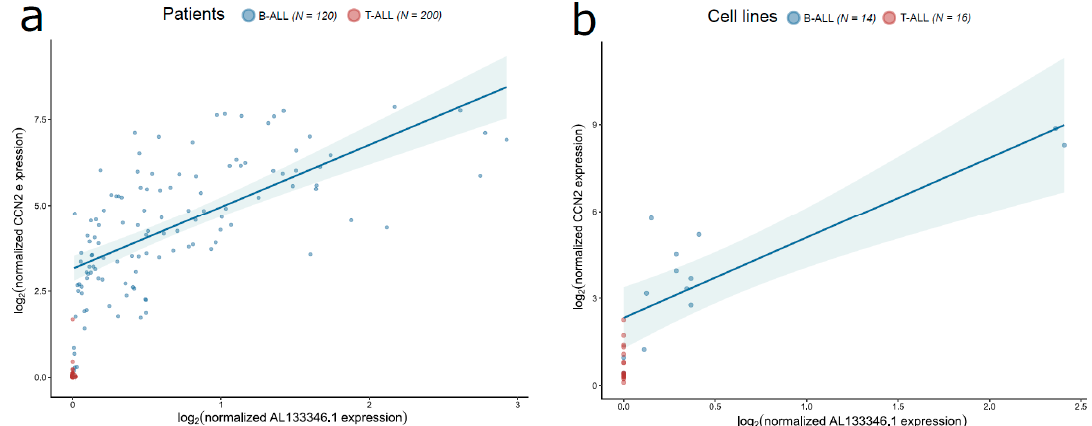
Figure 3. Comparison of AL133346.1/CCN2 expression between pediatric B ‐ ALL and T ‐ ALL samples from TARGET ( a ) and CCLE ( b ). The scatterplots are colored according to the ALL subtype. Sample sizes and gene expression correlation: TARGET 120 B ‐ ALL (Spearman correlation coefficient = 0.717, p < 0.0001) vs. 200 T ‐ ALL (Spearman correlation coefficient = 0.099, p = 0.163). CCLE: 14 B ‐ ALL (Spearman correlation coefficient = 0.799, p = 0.001) vs. 16 T ‐ ALL (Not available).